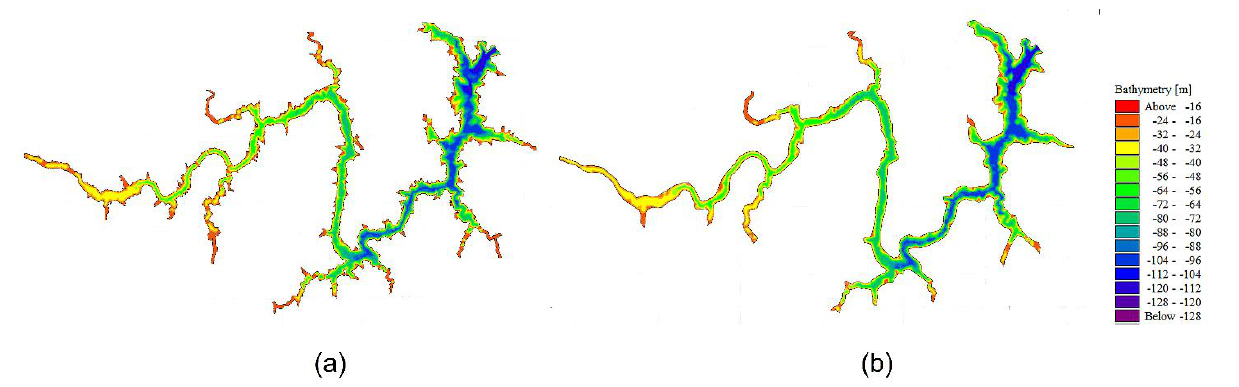
Figure 2. Smoothing on the edge of the calculated region: ( a ) before smoothing, ( b ) after smooth- ing.